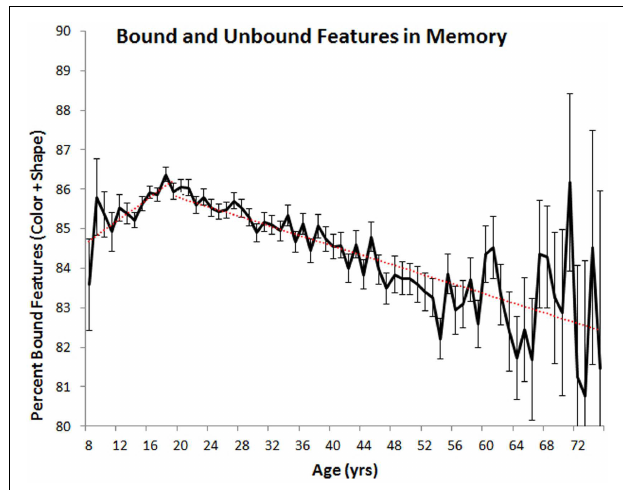
FIGURE 4 | Mean percentage of remembered colors and shapes that were correctly bound together (with standard error) plotted as a function of age. Red lines indicate best-fit linear